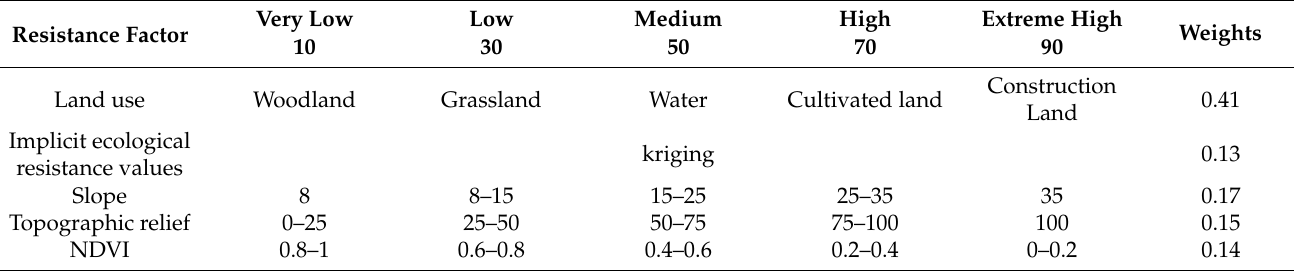
Table 5. Resistance factors and